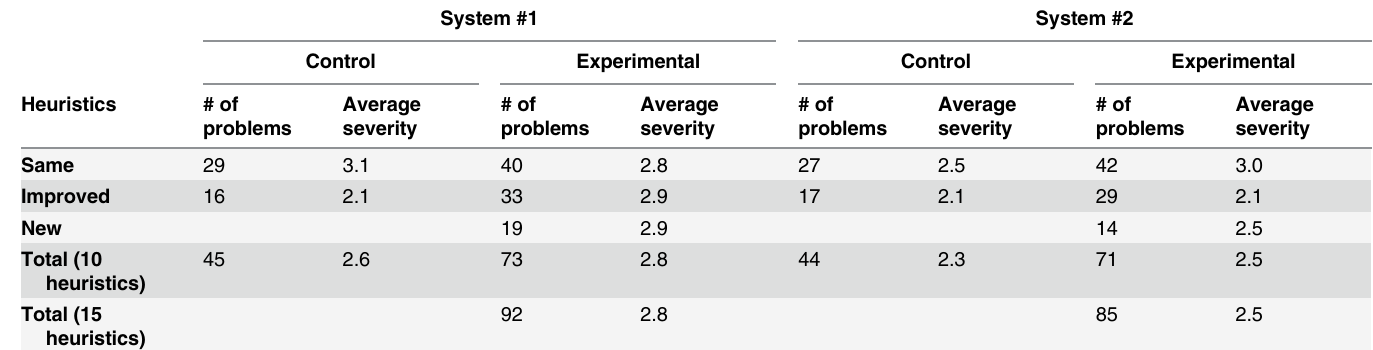
Table 8. Number of problems and average severity rating using different types of heuristics in both of the systems reported by control and experi- mental